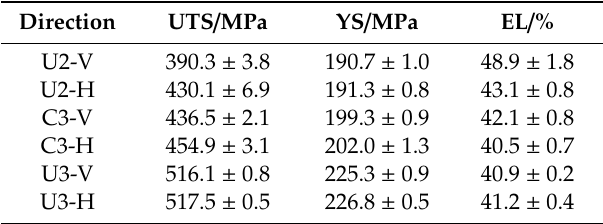
Figure 15. Comparison of stress-strain curves of cast C95220 alloys, U2, C3 and U3 samples (Inserted pictures represent the relationship between applying tension and grains direction in additive manufacturing samples, F means tensile force direction. Inserted picture at the top left is the microstructure of C95520 alloys). Table 2. Tensile properties of the WAAM samples.